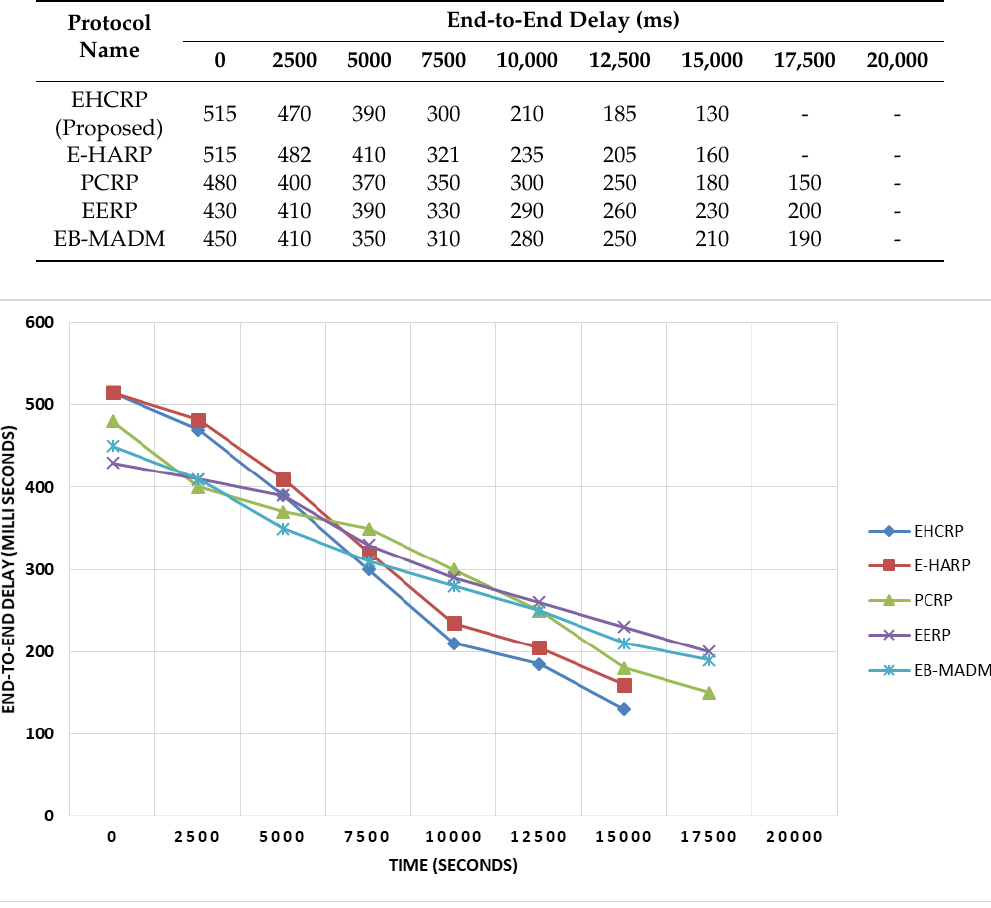
Figure 11. Breakdown of end-to-end delay.